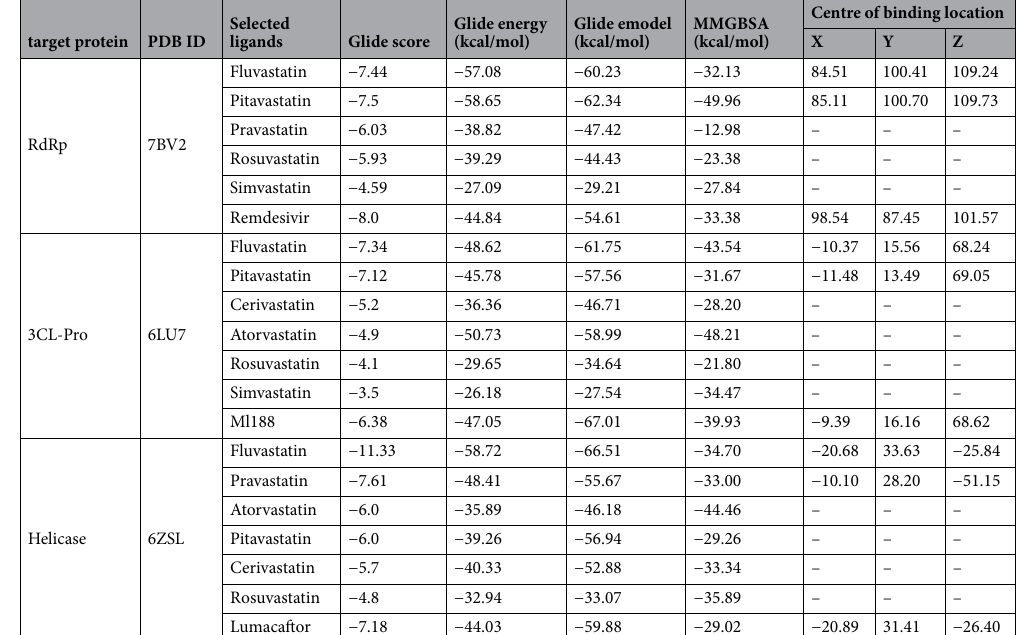
target protein PDB ID